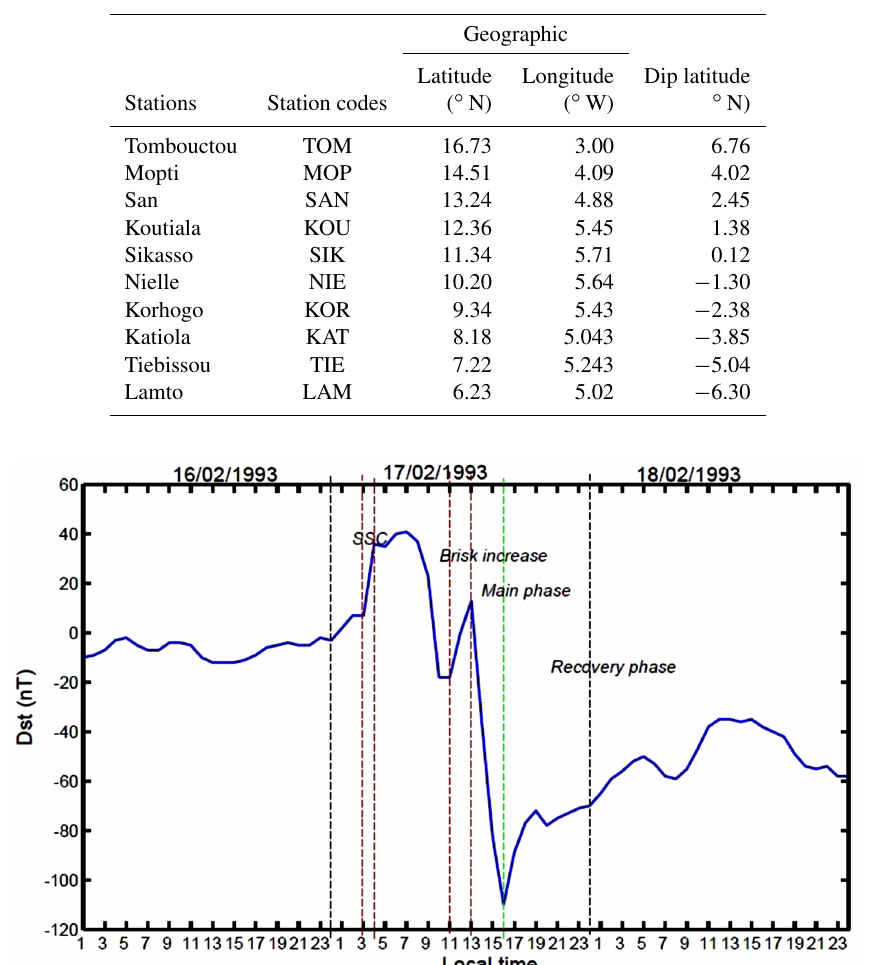
Figure 2. The Dst index from 16 to 18 February 1993. An ssc at 03:00LT starts the process of a moderate geomagnetic storm on 17 February 1993 with a daily Am = 64nT. At 11:00LT another brisk increase started. During the main phase of the storm, the Dst minimum value is − 110nT around 16:00LT. The Dst data were copied from the website